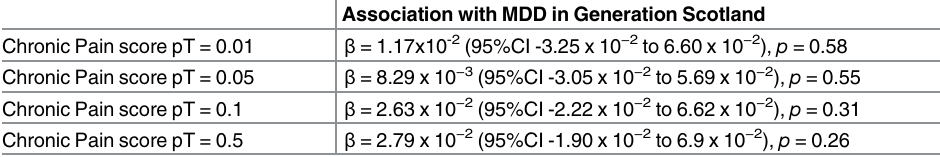
Table 2. Association of polygenic profile scores for chronic pain and MDD in GS:SFHS. Association with MDD in Generation Scotland Chronic Pain score pT = 0.01